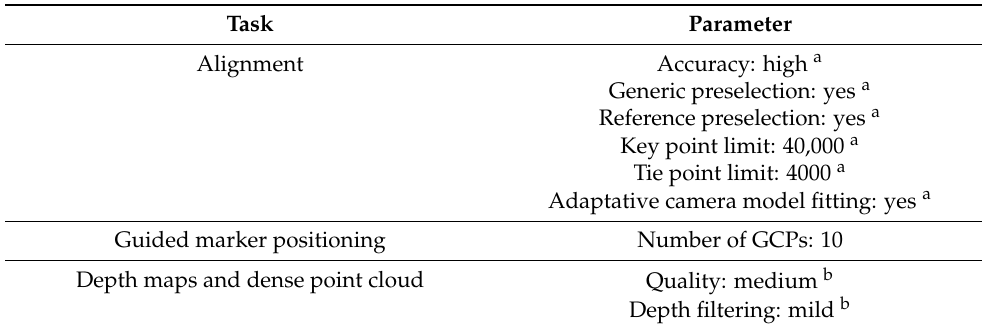
Table 3. Processing steps with corresponding parameters in Agisoft PhotoScan Professional software for the generation of 3D point cloud from UAS imagery. Task Parameter